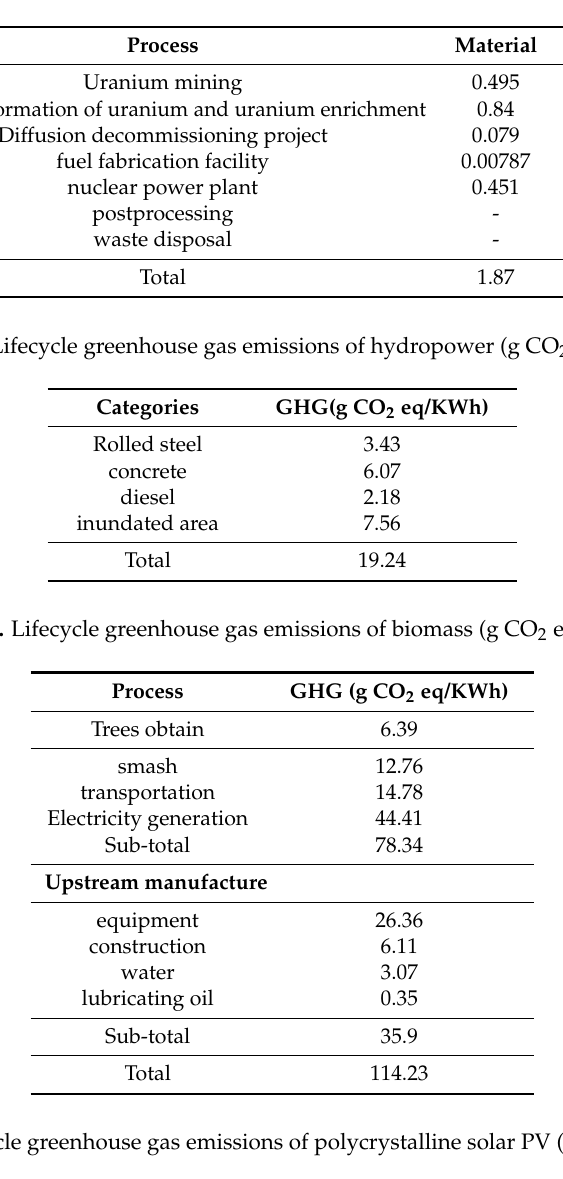
Table A3. Lifecycle greenhouse gas emissions of nuclear power (g CO 2 eq/KWh).